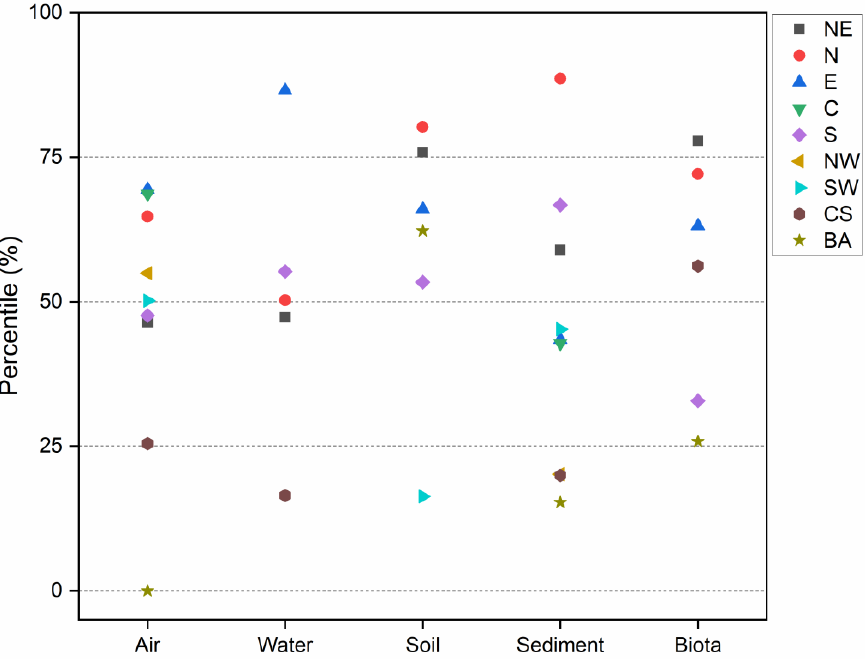
Figure 2. Percentile of SCCP concentrations in different regions according to environmental matrices. NE: Northeastern China; N: Northern China; E: Eastern China; C: Central China; S: Southern China; NW: Northwestern China; SW: Southwestern China; CS: China sea areas; BA: Background area.